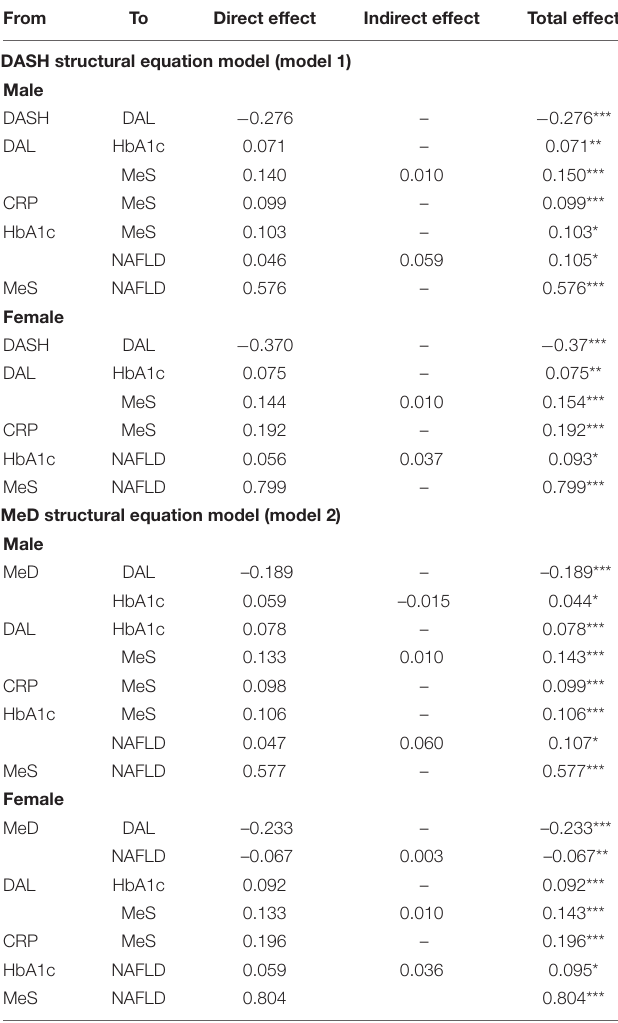
TABLE 2 | Standardized total effect, direct effect, and indirect effect of the association of DASH and MeD with NAFLD in Iranian adults of AmolCS. From